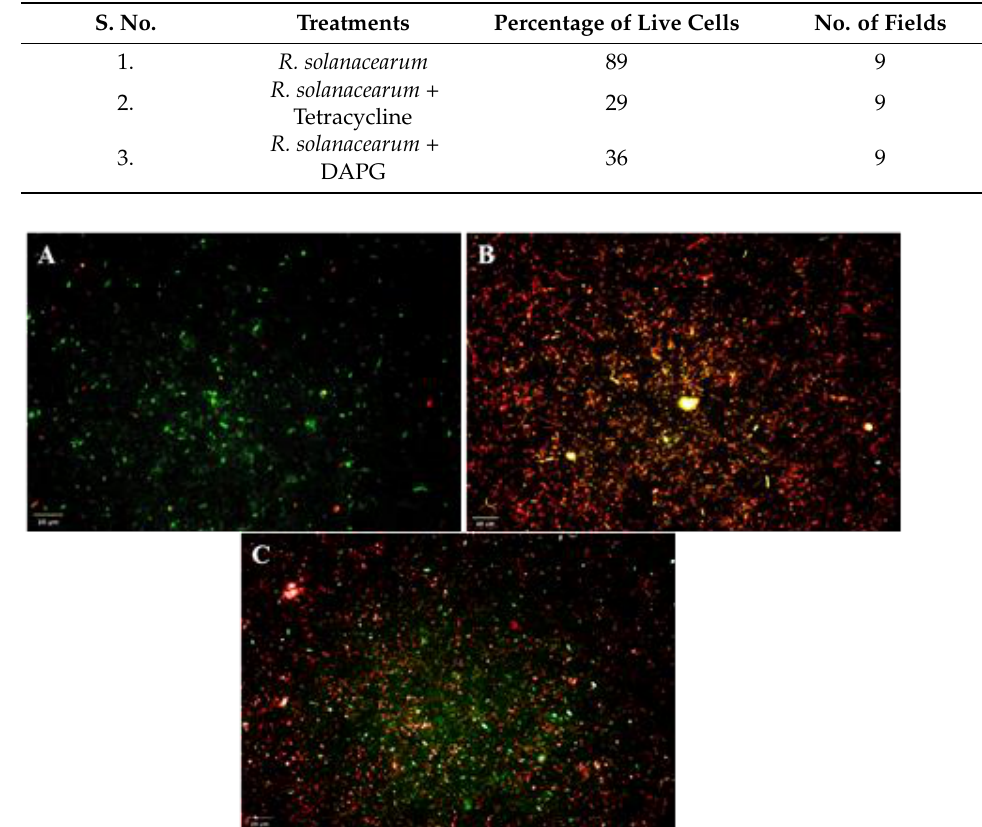
Figure 7. Live/dead assay of R. solanacearum in high content screening imaging system. Green and red stained cells considered as live and dead cells, respectively. ( A ) R. solanacearum alone (Control), ( B ) R. solanacearum treated with tetracycline at 90 µ g/mL and ( C )— R. solanacearum treated with DAPG at 90 µ g/mL. Scale bar: 20 µ